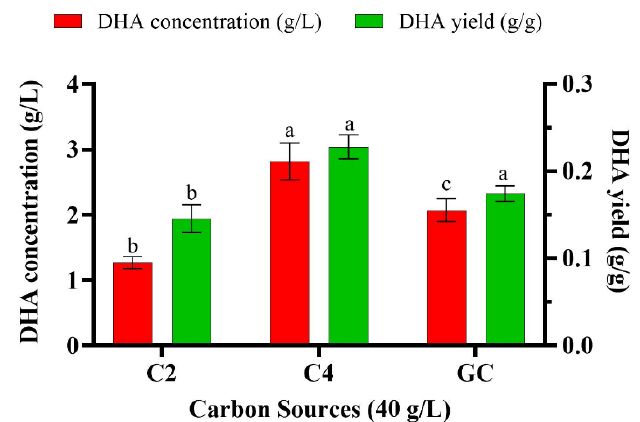
Figure 4. DHA concentration and yield of Aurantiochytrium sp. T66 cultivated in 40 g/L of C2, C4 or glucose. Error bars express the standard deviation of the mean (n = 3). Different letters (a,b,c) above the bars in each group of results indicate significant difference ( p < 0.05), based on one-way ANOVA with Tukey’s test.